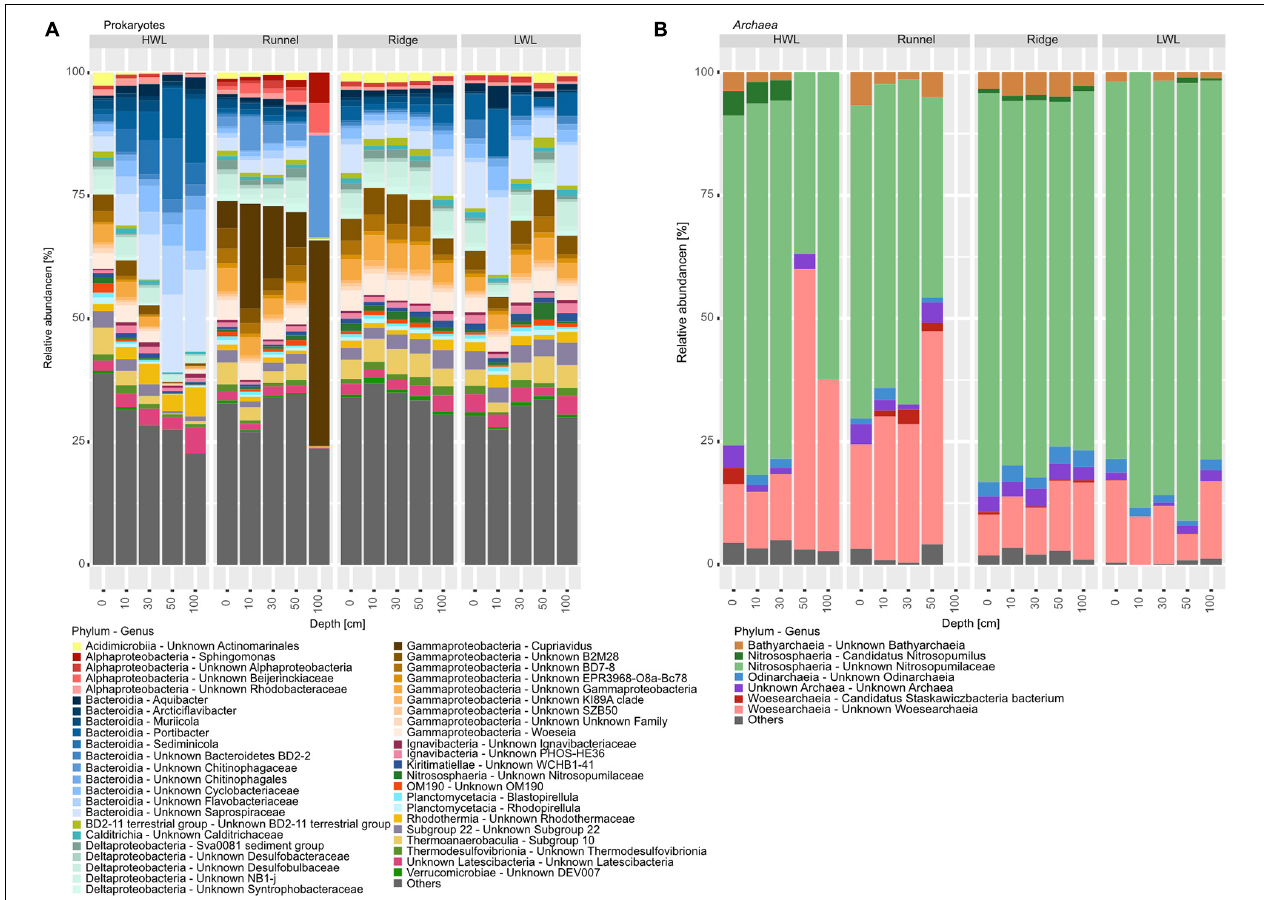
FIGURE 4 | Barplots of prokaryotic communities along the transect depicted on phylum and genus level. (A) Shows total prokaryotic diversity, while (B) zooms into the Archaeal diversity, due to their low relative abundances. Taxa below the abundance threshold were summarized as